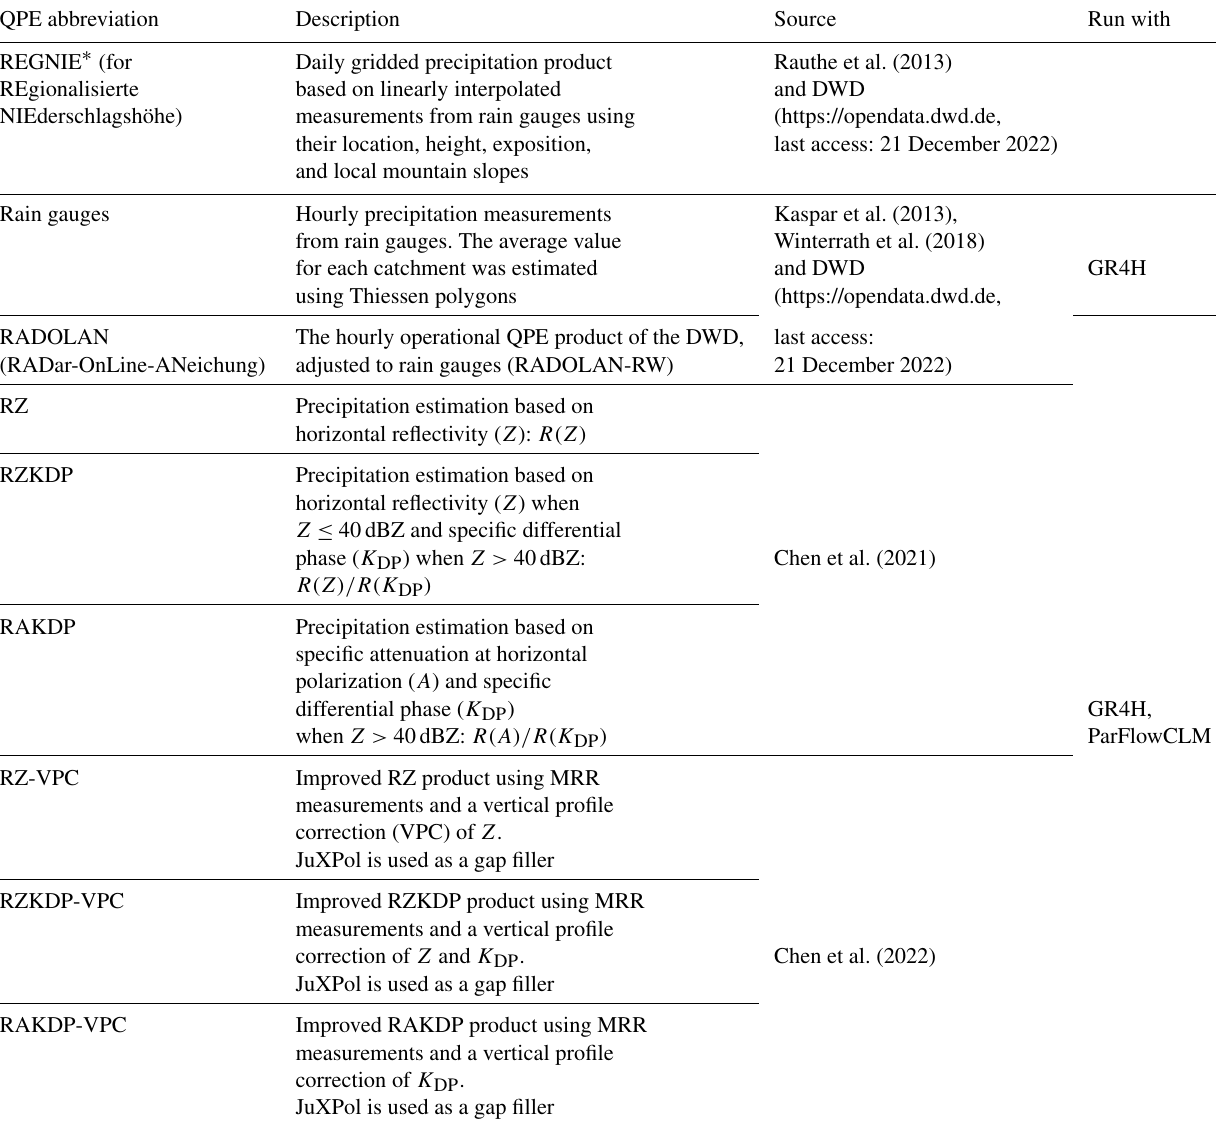
Table 2. Summary of QPE products used for 14 July 2021 for the study region. MRR refers to micro rain radar. JuXPol is an X-band radar located near Jülich (Fig.